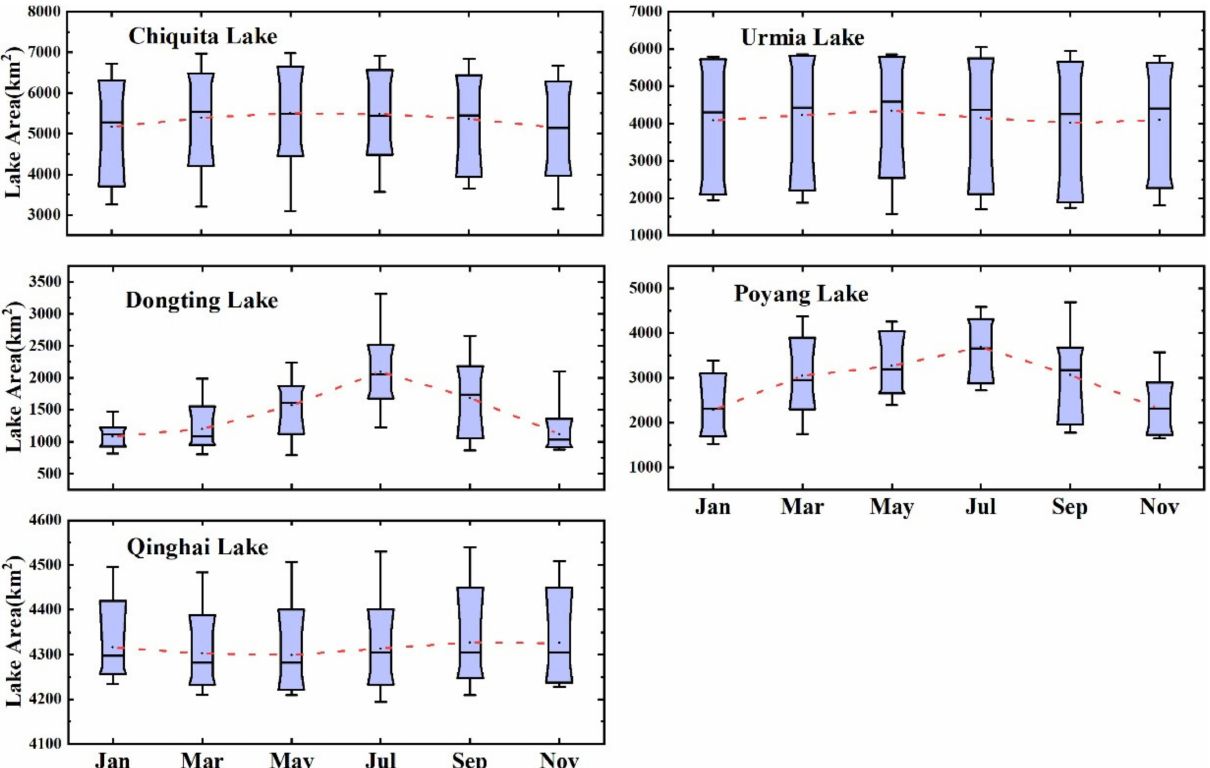
Figure 8. Illustration of intra-annual variation characteristics of surface water area for the five case lakes.